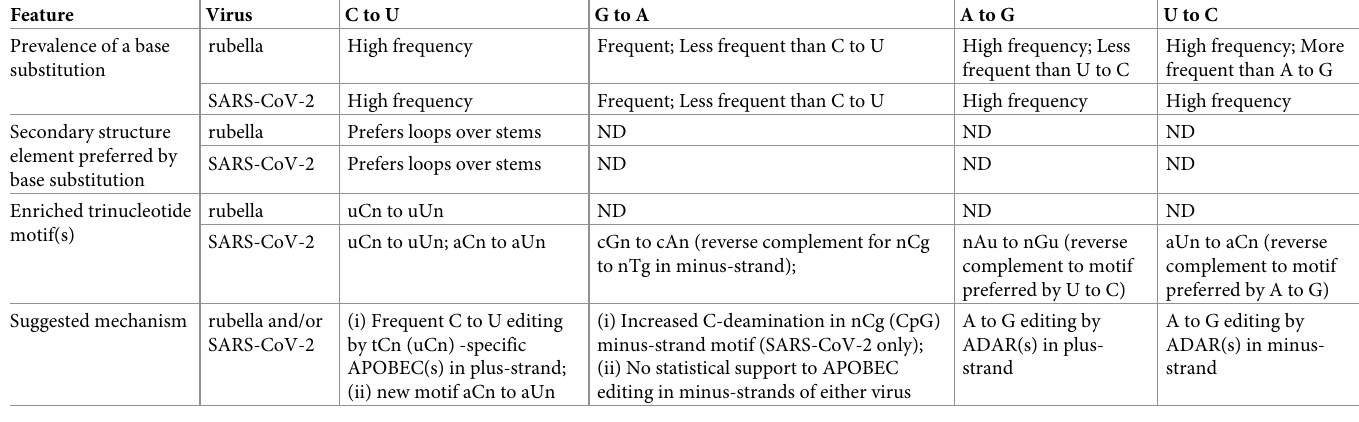
Table 1. Analyses of base substitutions prevailing in rubella virus and in SARS-CoV-2 plus-strand genomic